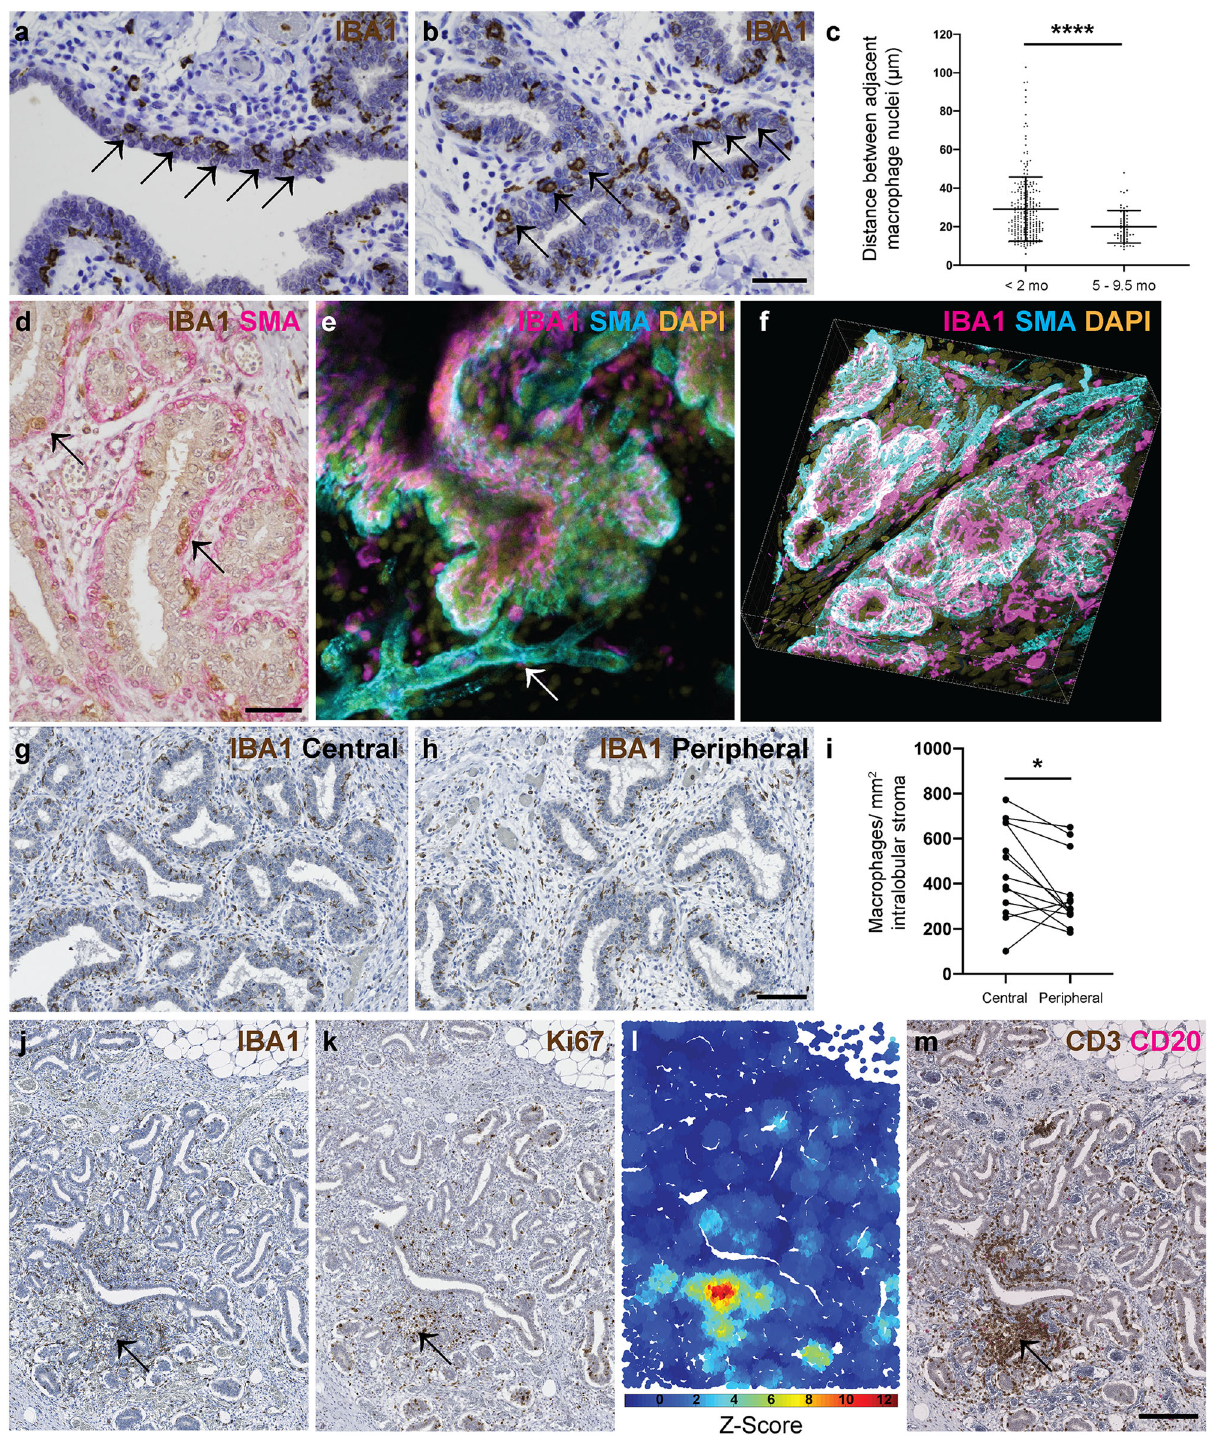
Fig. 4 Mammary macrophages exhibit spatial and temporal dynamics. a , b IHC for IBA1 reveals macrophage periodicity (arrows) in ducts ( a ) and ductules ( b ). c Scatter plot demonstrating that the distributions of inter-macrophage distance differ signi fi cantly between lambs aged <2 mo and 5 – 9.5 mo. Dots represent inter-macrophage distances from 13 individual lambs. Bars represent mean ± standard deviation. **** p < 0.0001. d IHC for IBA1 (brown) and alpha smooth muscle actin (SMA; pink). Arrows indicate macrophages. e , f 3D confocal microscopy of optically cleared ovine mammary tissue with IF for IBA1 (magenta) SMA (cyan) and DNA (DAPI; gold). Images represent 3D maximum intensity projections. Arrow indicates blood vessel. g , h IHC for IBA1 in central ( g ) and peripheral ( h ) foci. i Scatter plot demonstrating signi fi cantly reduced macrophage abundance in peripheral compared to central foci. Dots represent average macrophage density for individual lambs. * p < 0.05. j – m Serial sections demonstrating IHC for IBA1 ( j ) Ki67 ( k ) and CD3 (brown) and CD20 (pink) ( m ) with accompanying G-O plot for Ki67 ( l ) (scale ( d ) parameter = 250 px). Arrow indicates co-localisation of stromal macrophages, a Ki67 hotspot, and a CD3 + lymphocyte aggregate. Images are representative of 13 ( a , b , g , h ), and three ( d – f , j – m ) biological repeats; mo, months old. All IHC images have haematoxylin counterstain. Scale bar = 40 μ m ( a , b , d ); 100 μ m ( g , h ); 200 μ m ( j , k , m